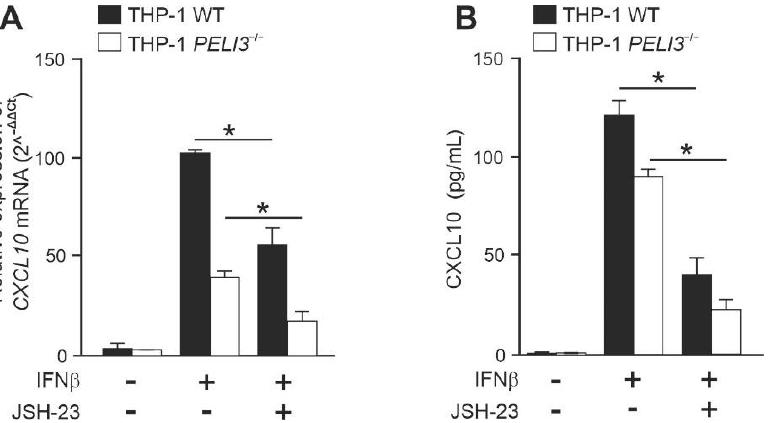
Figure 3. IFN β -dependent production of CXCL10 is mediated by NF- κB, but in Pellino3 independent mechanism. Wild type (WT) and PELI3 −/− THP-1 cells were pretreated with DMSO ( −/− ) or JSH-23 (5 µM) for 1 h. Next, the cells were treated with IFNβ (1000 U/mL) for 4 h ( A ) or 16 h ( B ). ( A ) Thereafter, total RNA was isolated and reverse-transcribed. Quantitative real-time PCR (2 −(ΔΔCT) ) was used to assay the expression levels of CXCL10. Relative expression values were normalized to the HPRT1 reference gene, and non-treated cells were assigned an arbitrary value of 1. ( B ) CXCL10 level was measured by ELISA. All results presented are representative of at least three independent